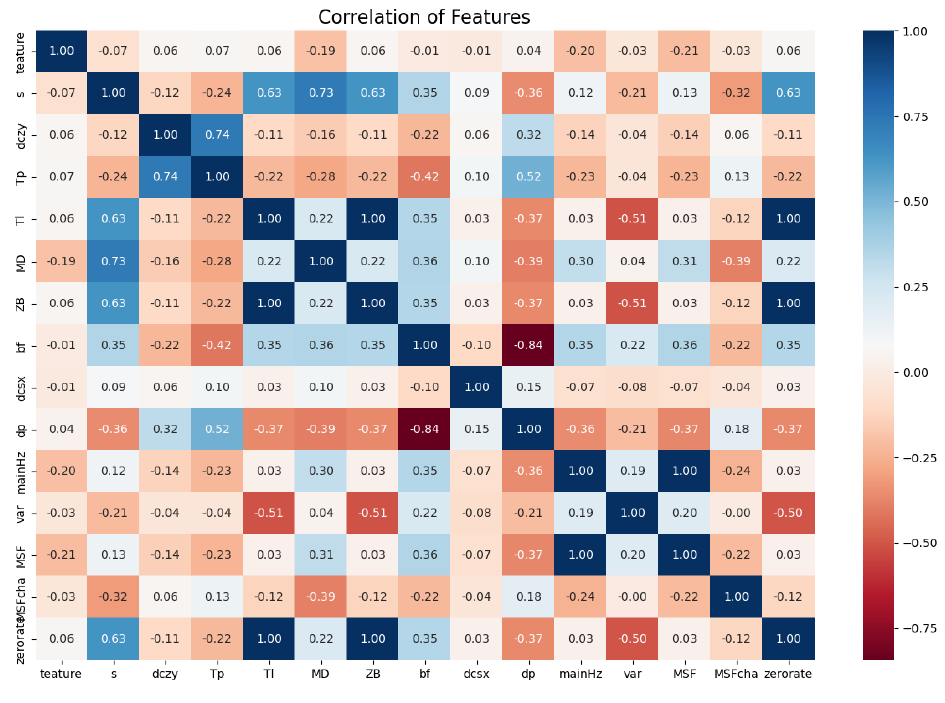
Figure 4. Heat map of the material dataset.